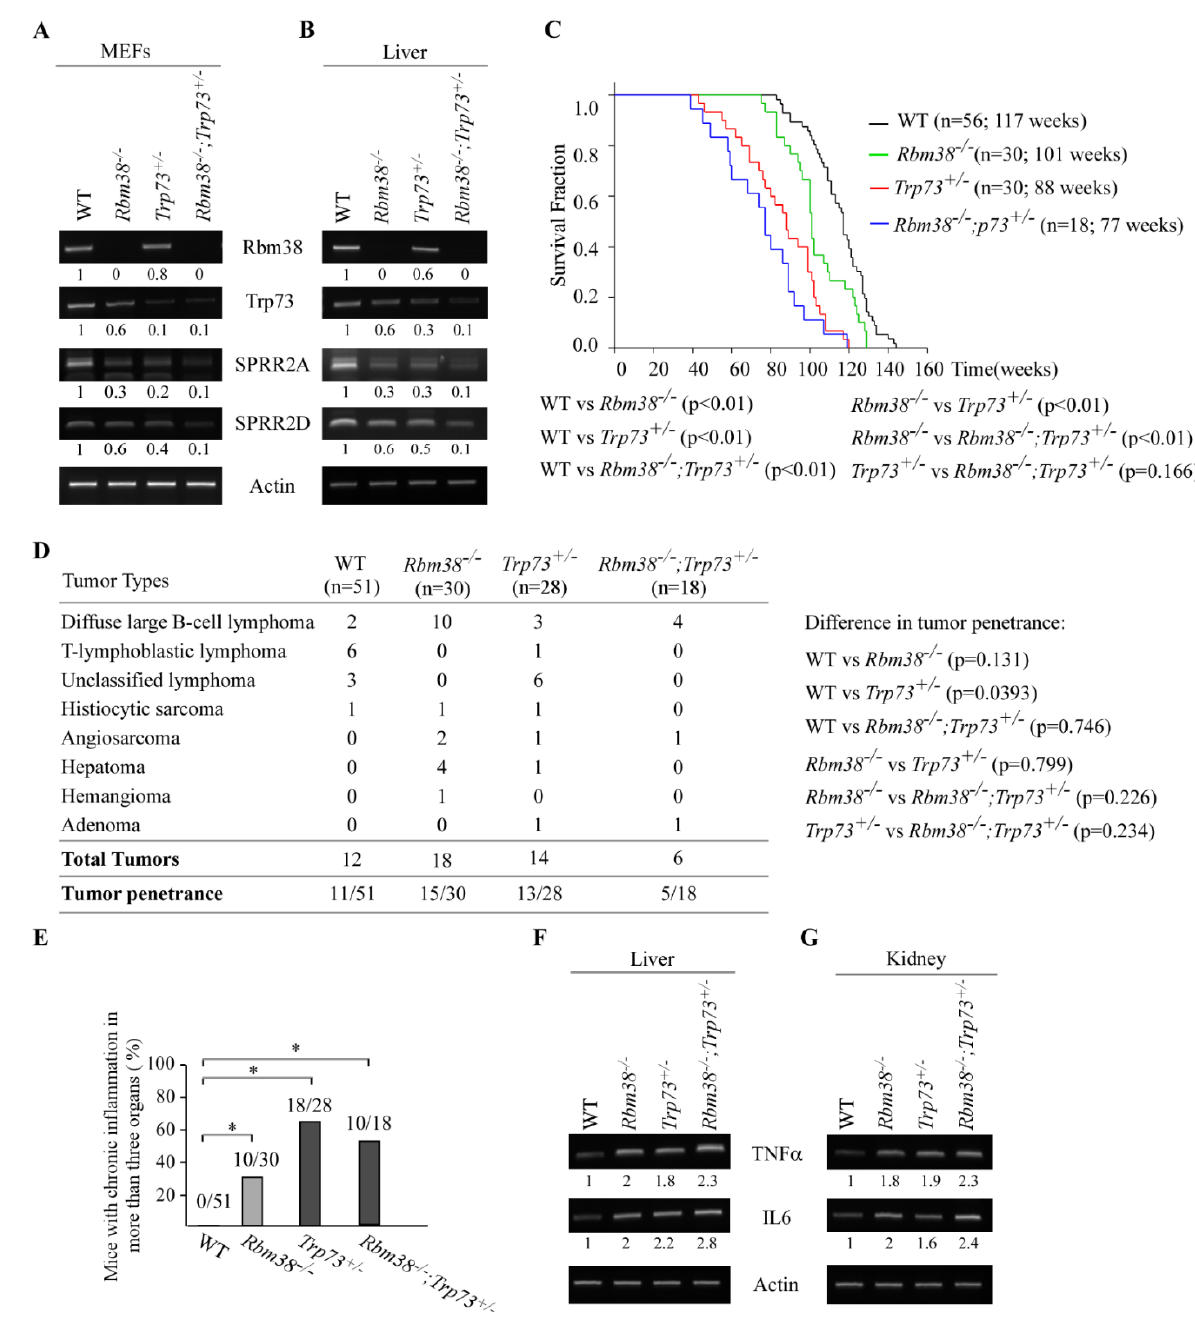
Figure 5. Loss of Rbm38 cooperates with Trp73 deficiency to modulate chronic inflammation, potentially via SPRR2A/2D. ( A–B ) The levels of Rbm38, Trp73, SPRR2A, SPRR2D, and actin was examined by RT ‐ PCR analysis using WT, Rbm38 ‐ / ‐ , p73 +/ ‐ , and Rbm38 ‐ / ‐ ;Trp73 +/ ‐ MEFs ( A ) and livers ( B ). ( C ) Kaplan–Meyer survival curves of WT ( n = 56), Rbm38 ‐ / ‐ ( n = 30), Trp73 +/ ‐ ( n = 30), and Rbm38 ‐ / ‐ ;Trp73 +/ ‐ ( n = 18) mice. ( D ) Tumor spectrum and burden in WT ( n = 56), Rbm38 ‐ / ‐ ( n = 30), Trp73 +/ ‐ ( n = 28), and Rbm38 ‐ / ‐ ;Trp73 +/ ‐ ( n = 18) mice. ( E ) The numbers and percentages of WT, Rbm38 ‐ / ‐ , Trp73 +/ ‐ , and Rbm38 ‐ / ‐ ;Trp73 +/ ‐ mice with chronic inflammation in three or more organs. * indicates p<0.05 (by student t ‐ test). ( F–G ) The levels of TNF α and IL6 transcripts were examined in the livers ( F ) or kidneys ( G ) from WT, Rbm38 ‐ / ‐ , Trp73 +/ ‐ , and Rbm38 ‐ / ‐ ;Trp73 +/ ‐ mice.